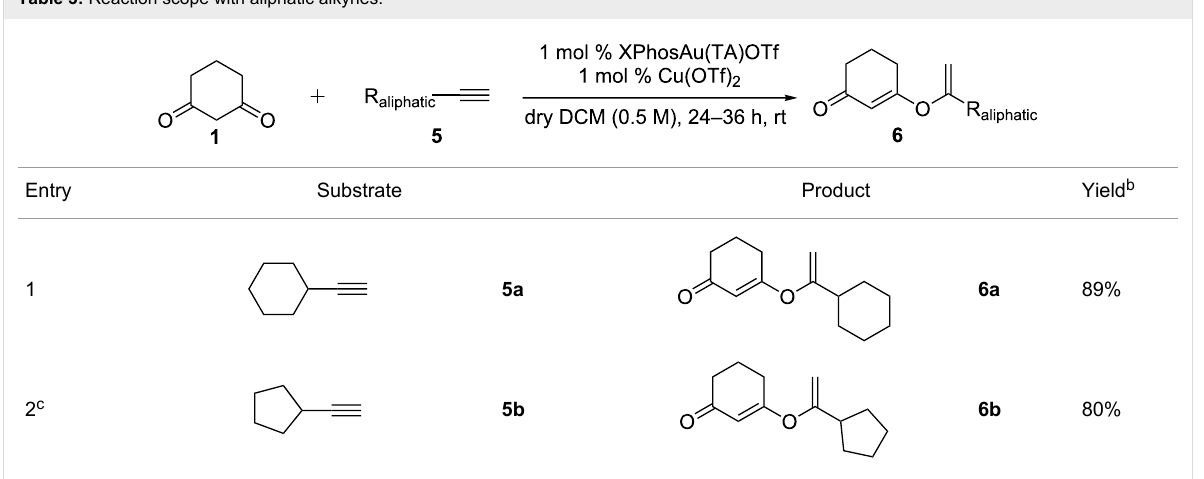
Table 3: Reaction scope with aliphatic alkynes.